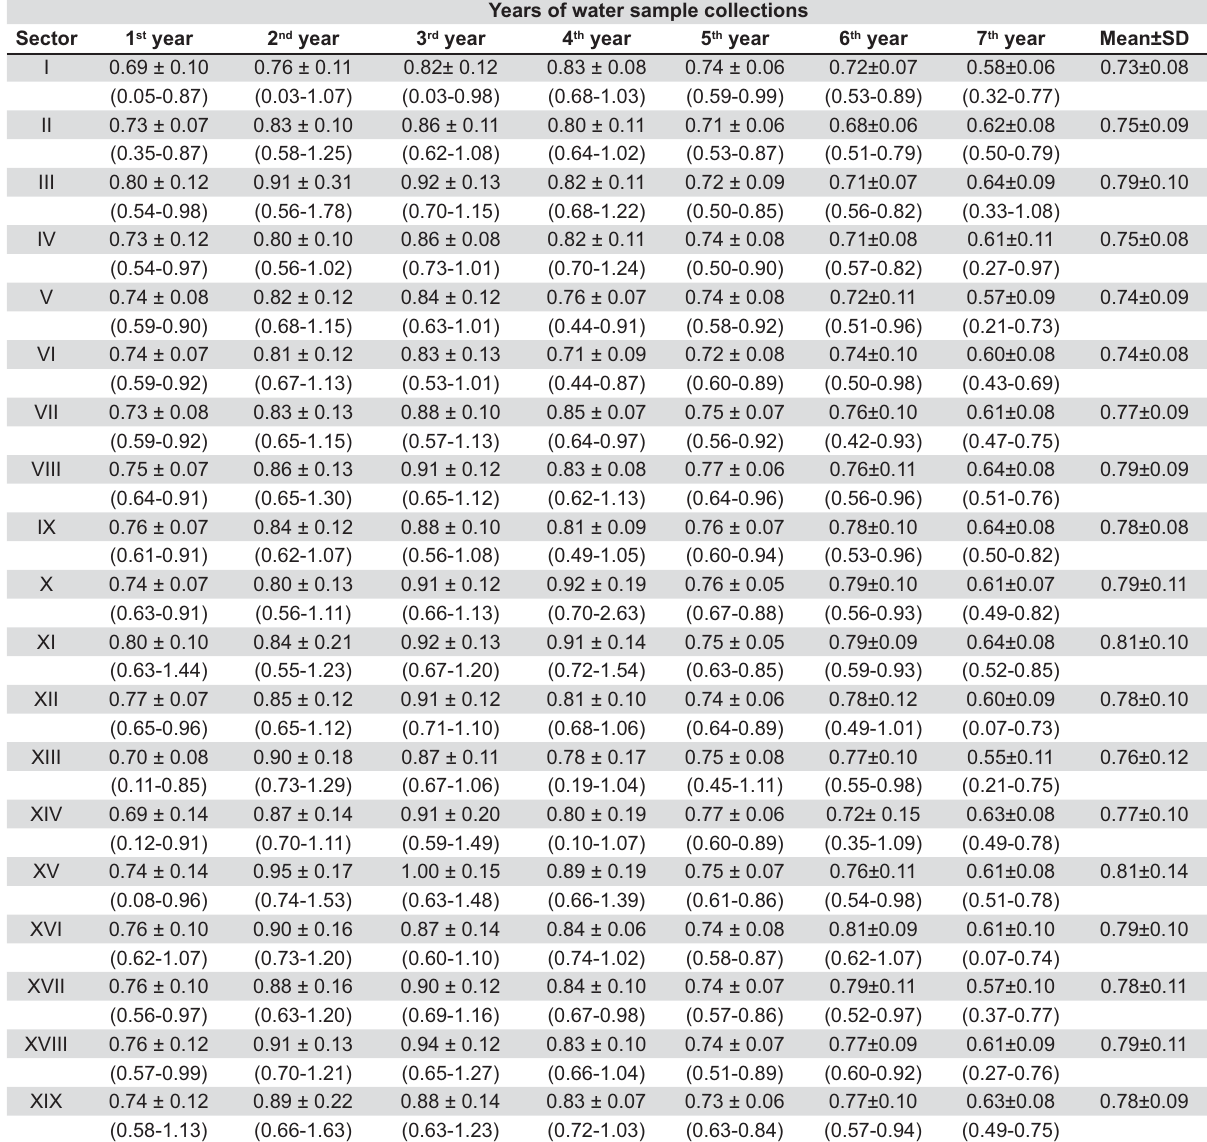
Total number of samples: 4,641. Values represent mean ± standard deviation (SD). Data in parenthesis represent minimum and maximum